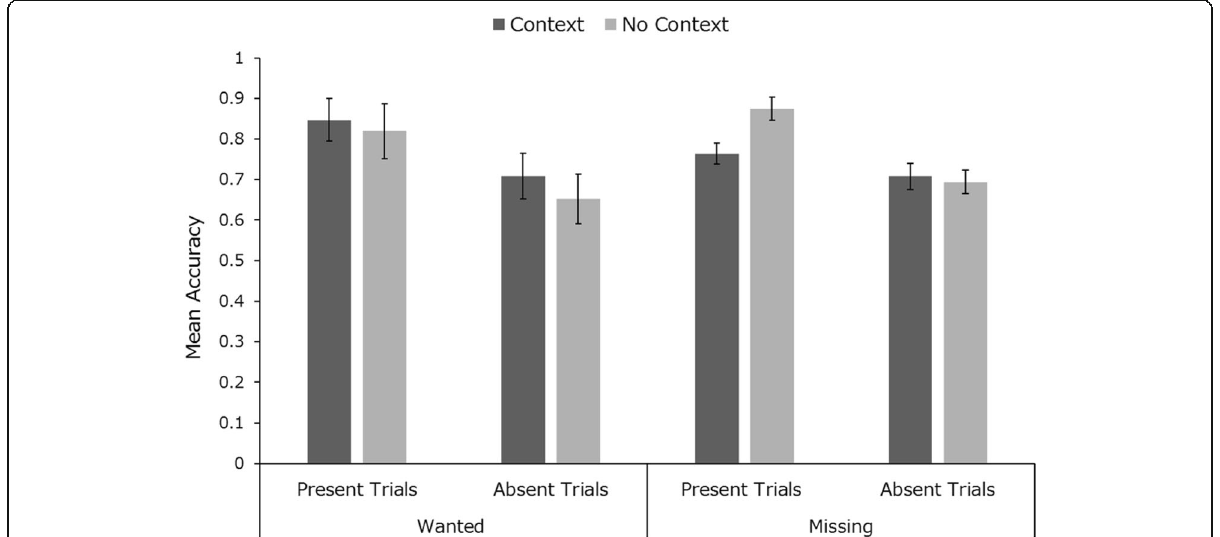
Fig. 8 Mean identification accuracy across target exposure, context and trial types in study 4. Error bars represent within-subjects standard error (Cousineau,